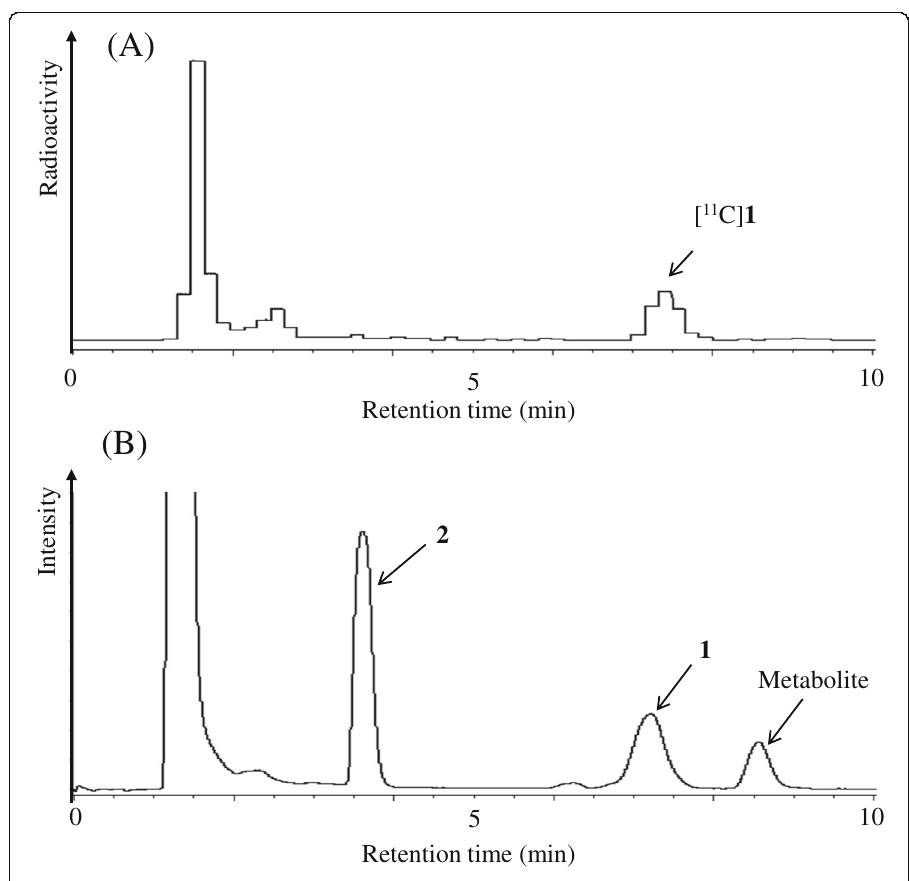
Fig. 4 Radio- (A) and UV-HPLC (B) chromatograms from metabolite analyses of mouse plasma at 30 min post-injection with [ 11 C] 1 and 1 (50 mg/kg). The injected dose of [ 11 C] 1 was 26 – 30 MBq (0.38 – 0.45